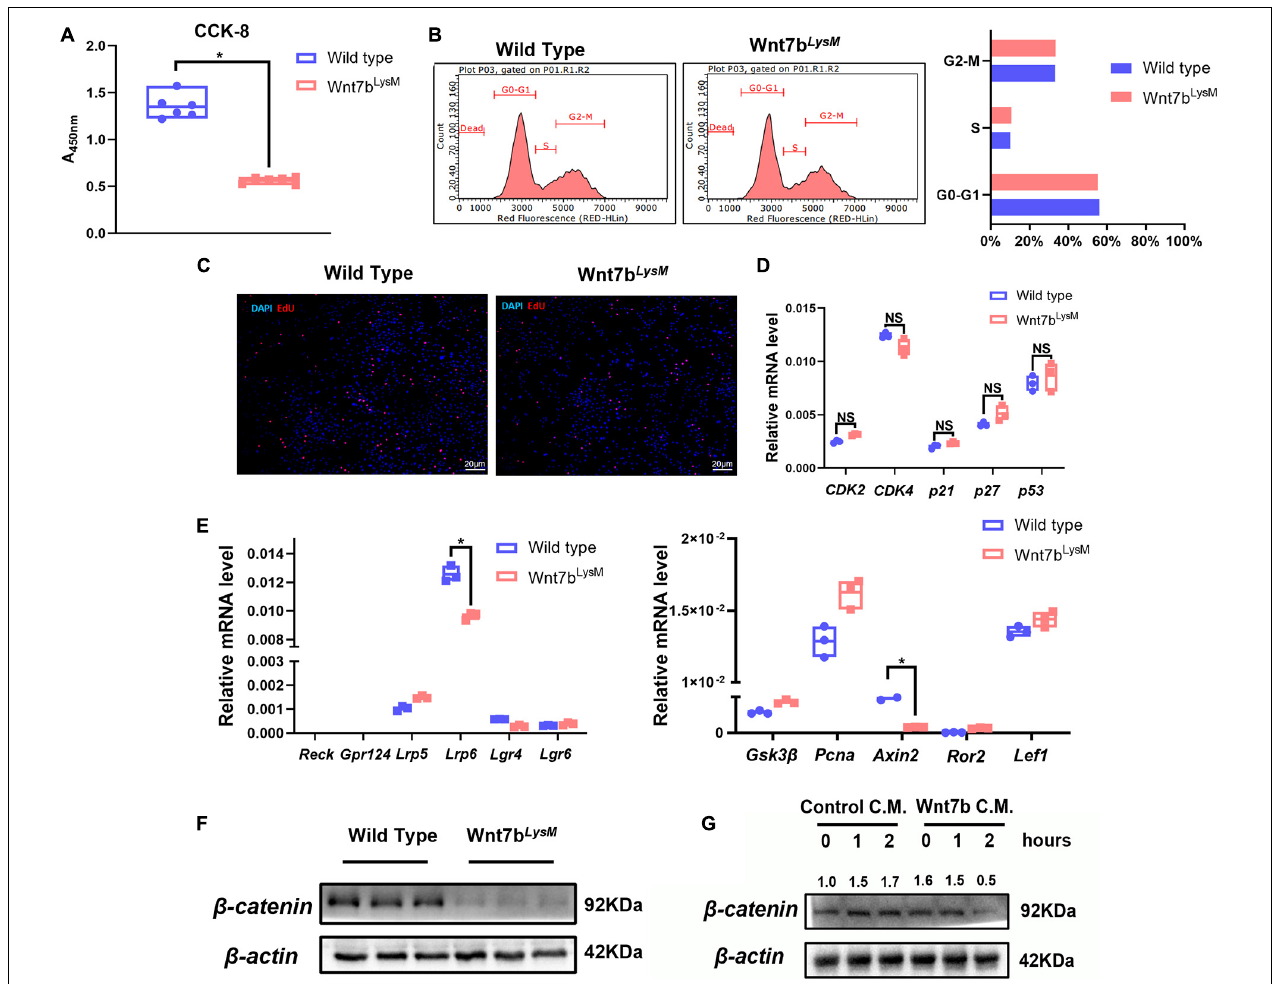
FIGURE 3 | Wnt7b suppressed canonical Wnt pathway in BMMs. (A) Cell Count Kit-8 (CCK-8) of BMMs derived from WT or Wnt7b LysM mice was performed to assessed cell viability. (B) Cell cycle distribution detected by flow cytometry analysis. (C) Representative images of 5-ehtynyl-2 (cid:48) -deoxyuridine (EdU) staining of BMMs derived from WT or Wnt7b LysM mice. (D) Transcriptional levels of cell-cycle-related genes ( CDK2 , CDK4 , p21 , p27 , and p53 ) determined by real-time PCR. (E) Expression levels of genes including Wnt receptors ( Reck , Gpr124 , Lrp5/6 ) and Wnt-related genes ( Gsk3 β , Axin2 , Ror2 , Lef1 , and Pcna ) were determined by real-time PCR. (F) Protein level of β -catenin in BMMs isolated from WT or Wnt7b LysM mice. (G) Raw264.7 cells were treated with conditional medium from 293FT cell line transfected with adeno-GFP or adeno-Wnt7b for the indicated period. Whole-cell lysates were collected for Western blot detection for β -catenin. The relative densities of blots are shown on top. N = 3. * p < 0.05; NS: not